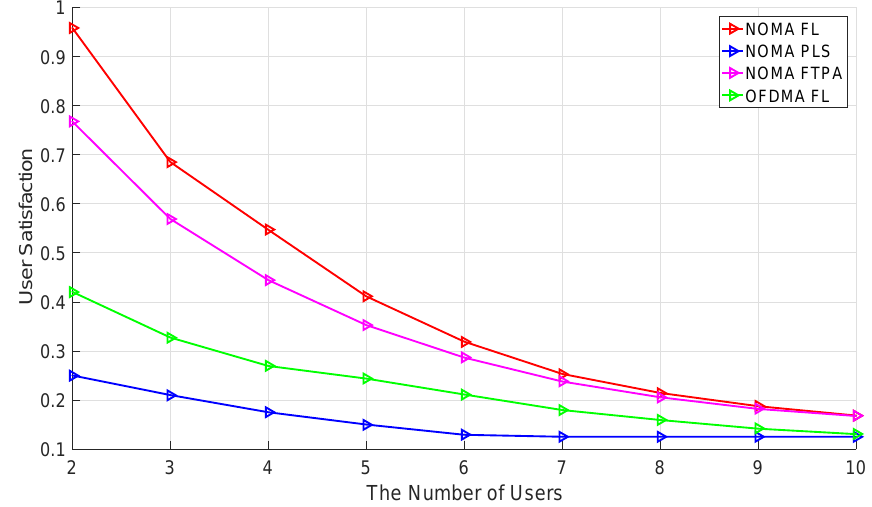
Figure 5. Comparisons of user satisfaction with the QoS expectation at 20